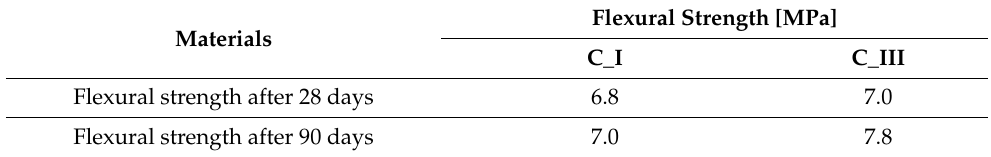
Table 7. Influence of the cement type on flexural strength after 7, 28 and 90 days of maturation.